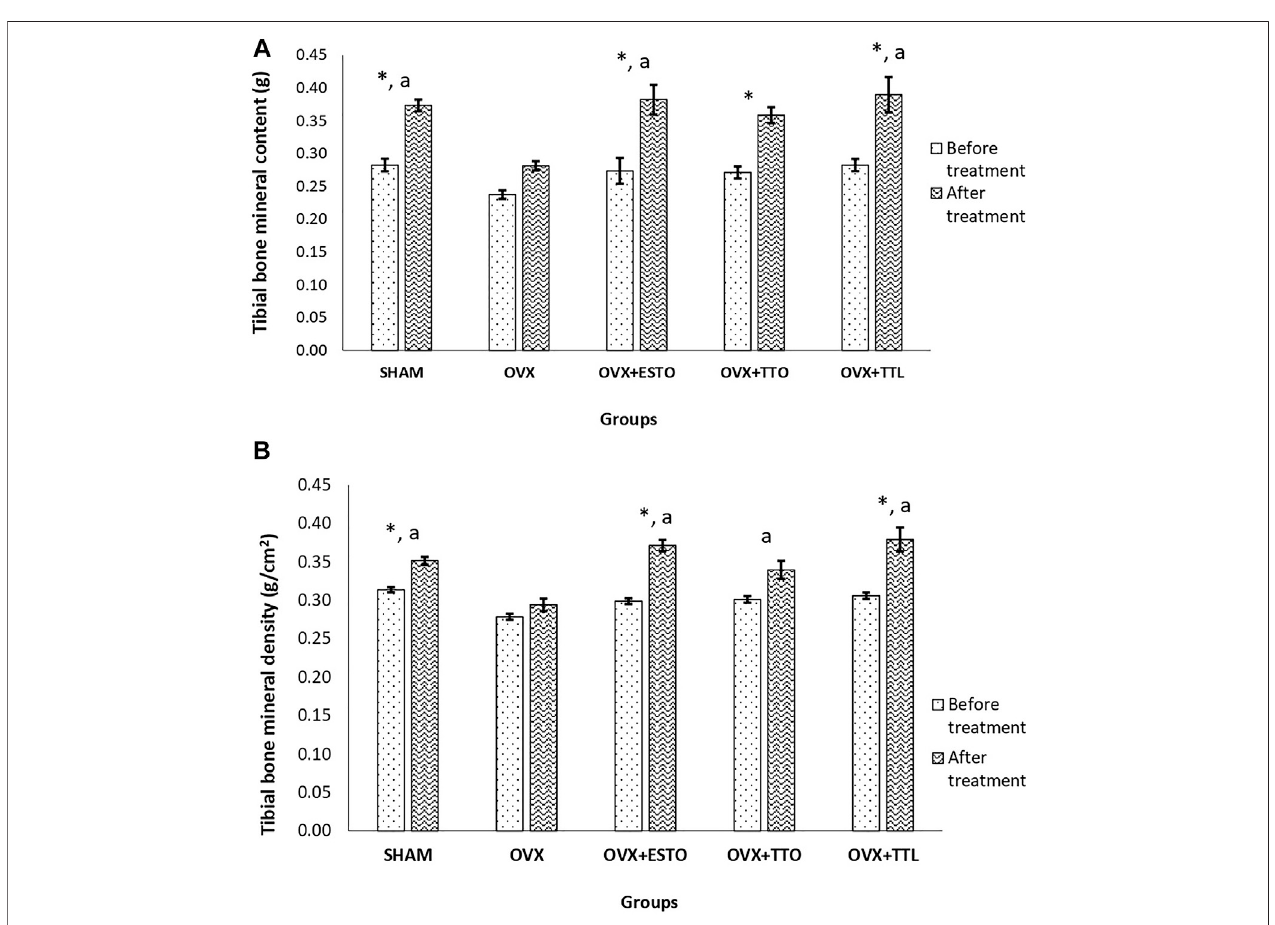
FIGURE 4 | DEXA Parameters (pre- and posttreatment). (A) Bone mineral content of the tibial bone. (B) Bone mineral density of the tibial bone. SHAM, sham- operated group; OVX, ovariectomized control group; OVX + ESTO, ovariectomized + oral estrogen; OVX + TTO, ovariectomized + daily oral tocotrienol; OVX + TTL, ovariectomized + IO injection of tocotrienol+ PLGA. *Signi fi cant difference( p < 0.05) when compared before and after treatment. a Signi fi cant difference ( p < 0.05) when compared with the ovariectomized control group (OVX). The data were expressed as mean + SEM.